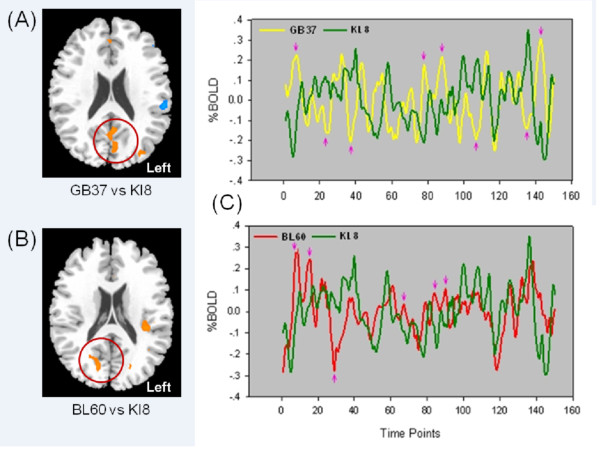
Illustration of variations of modulating effect of acupuncture over different acupoints. Comparisons of the functional connectivity were conducted between the visual acupoint group (GB37 or BL60) and the non-visual acupoint group (KI 8) during the late phase of acupuncture (Run 3): (A) GB37 vs. KI 8; (B) BL60 vs. KI8. The two sample t-test were used to determine significant between-group differences (P < 0.005 with a cluster size of 5 voxels). (C) The averaged time courses of fMRI BOLD signals in the occipital lobe, where showed significant between-group differences (circles on A and B). The temporal responses revealed almost opposite response patterns after stimulations over visual acupoint and the non-visual acupoint, i.e. GB37 vs. KI 8 and BL60 vs. KI8. The correlation coefficient between GB37 and KI 8 was -0.35 (P < 0.05, Bonferroni correction) and that of BL60 vs. KI8 was -0.18 (P < 0.05, Bonferroni correction).